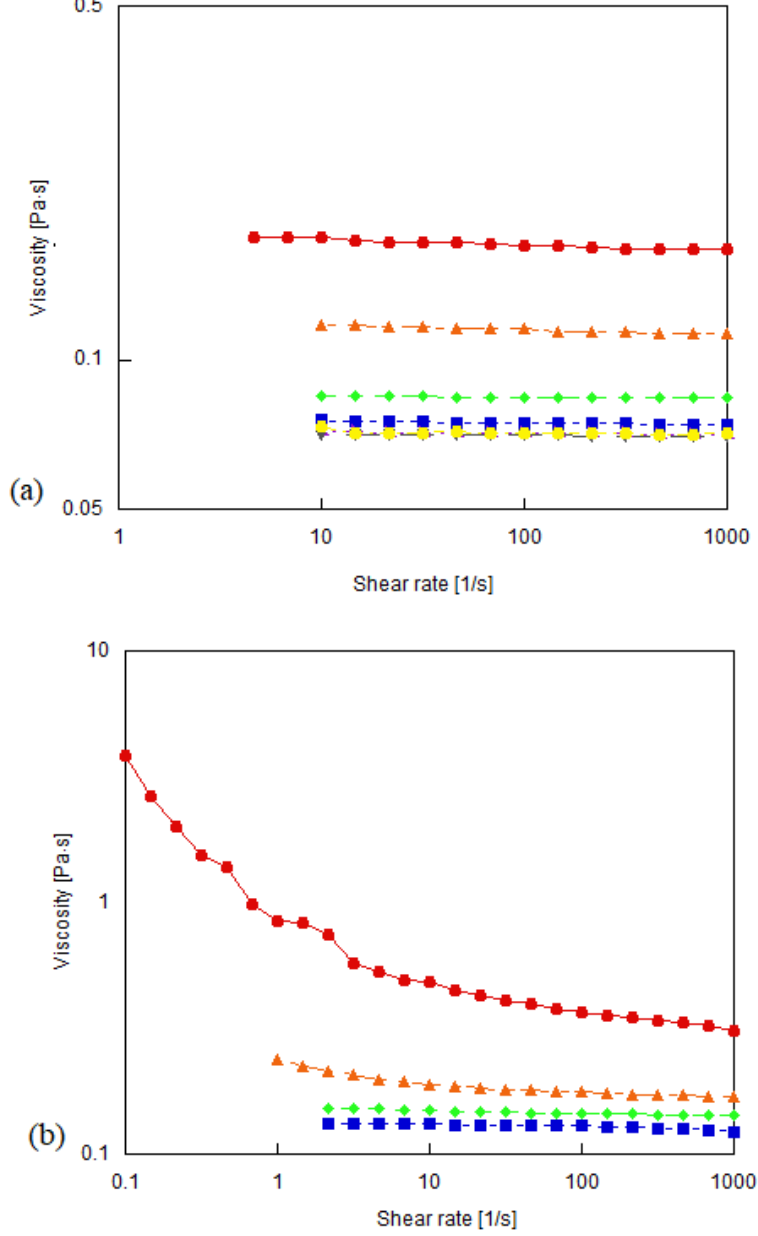
Figure 14. Steady shear rate flow behavior of the ( a ) GO of 2 h ( b ) GO of 96 h of oxidation for concentrations of: ● red—80 mg/mL, ▲ orange—40 mg/mL, ♦ green—20 mg/mL, ■ blue—10 mg/mL, concentrations of: red—80 mg / mL, (cid:78) orange—40 mg / mL, (cid:7) green—20 mg / mL, (cid:4) blue—10 mg / mL, (cid:73) • ► purple—1 mg/mL, ▼ grey—0.1 mg/mL and ● yellow—0 mg/mL. purple—1 mg / mL, (cid:72) grey—0.1 mg / mL and yellow—0 mg / •